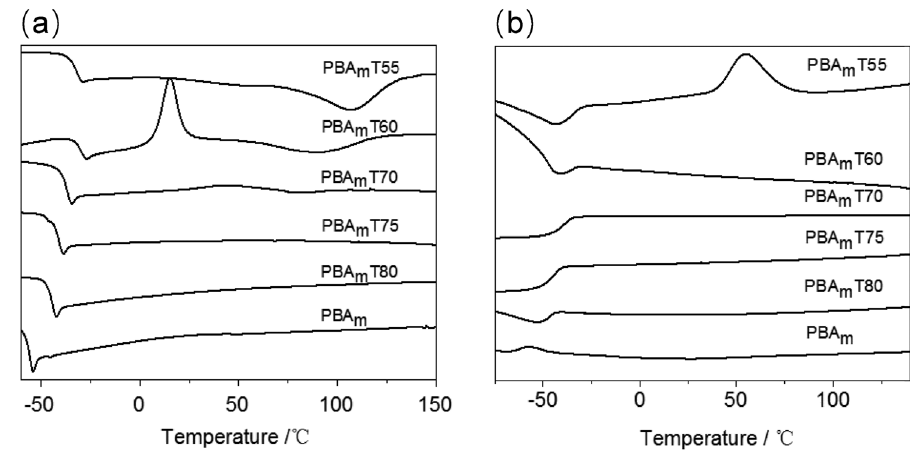
Figure 2: DSC thermograms of PBA m and PBA m T copolyesters. The curves were obtained during the second heating ( a ) and cooling runs ( b ) , while the fi rst heating run was to erase thermal history.